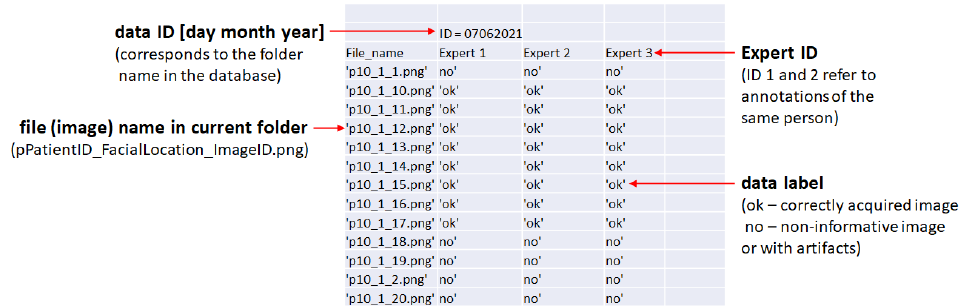
Figure 4. ID_DataDesc.xls file